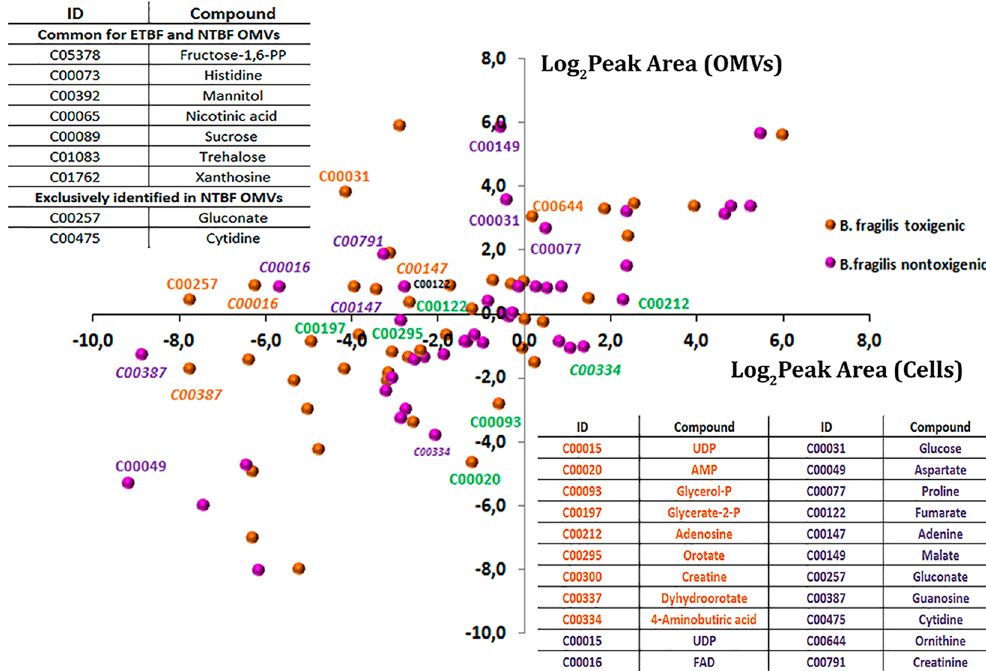
Figure 6. Comparative analysis of the relative representation of metabolites in cells and vesicles. Correlation analysis of the representation of the metabolites identified in ETBF/NTBF OMVs and cells. Metabolites are indicated by orange (identified in ETBF OMVs) or pink (identified in NTBF OMVs) circles. The coordinates of each circle indicate the mean of the logarithmic peak area calculated for metabolites identified in OMVs and cells, respectively. Metabolites highly represented in ETBF OMVs compared with ETBF cells are signed in orange color. Metabolites highly represented in NTBF OMVs compared with NTBF cells are signed in purple color. Metabolites highly represented in ETBF/NTBF cell compared with ETBF/NTBF OMVs are signed in green color (according Table S6-2). The table located in the upper left corner contains metabolites that were not detected in cells but only in OMVs. The table in the right bottom contains the decryption of the KEGG nomenclature. The full data represented in Table